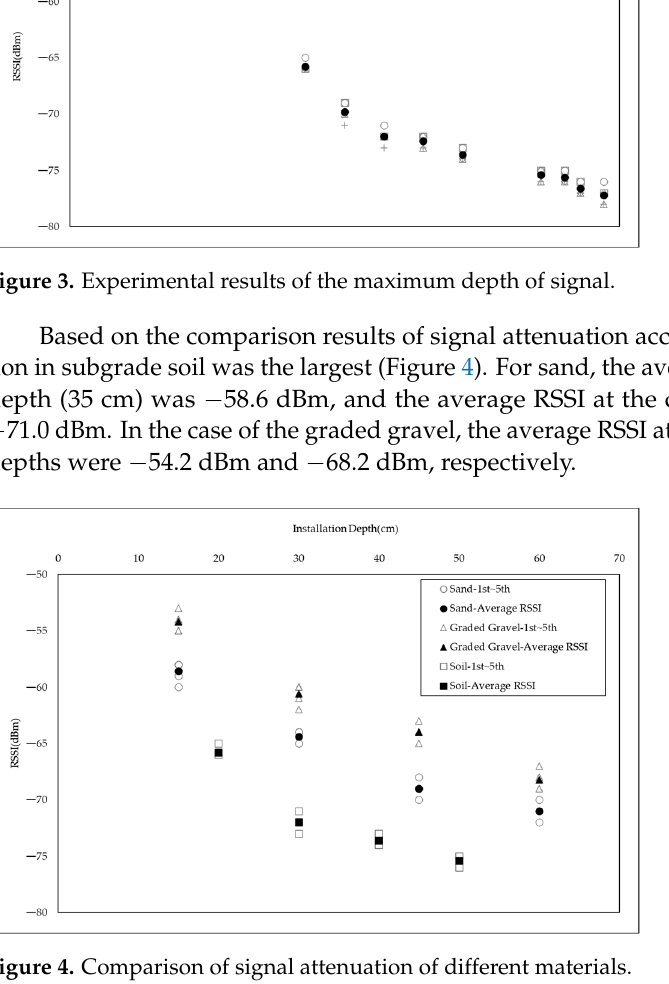
Figure 4. Comparison of signal attenuation of different materials.